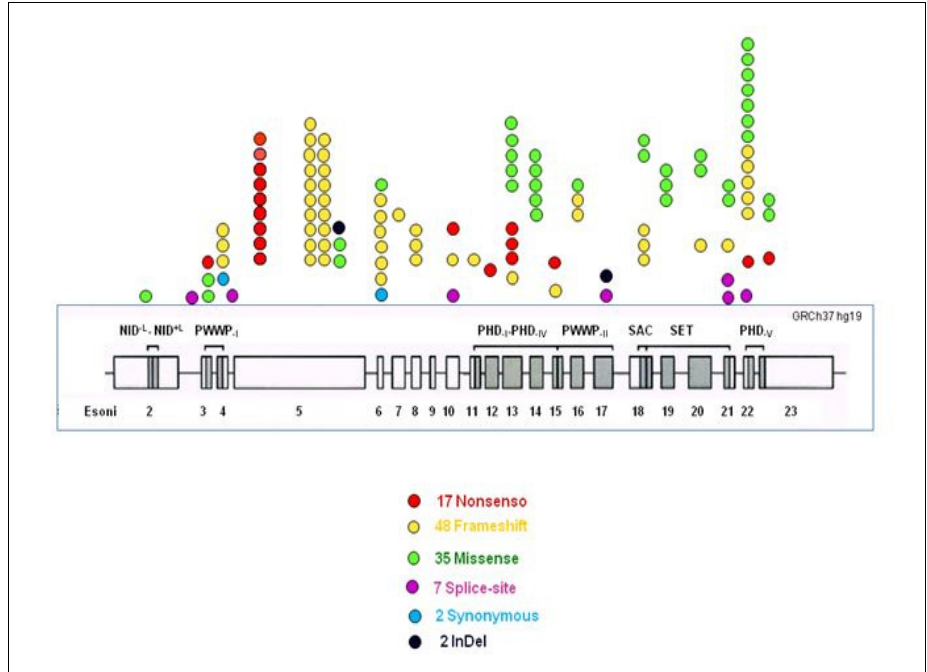
Figure 3. Schematic representation of the NSD1 protein domain and localization of 115 novel variants identified in this study. We show the color legend for the missense, nonsense, ins/dels, splicing, and intragenic deletions. Exons and introns are in scale and intronic variants are not reported.